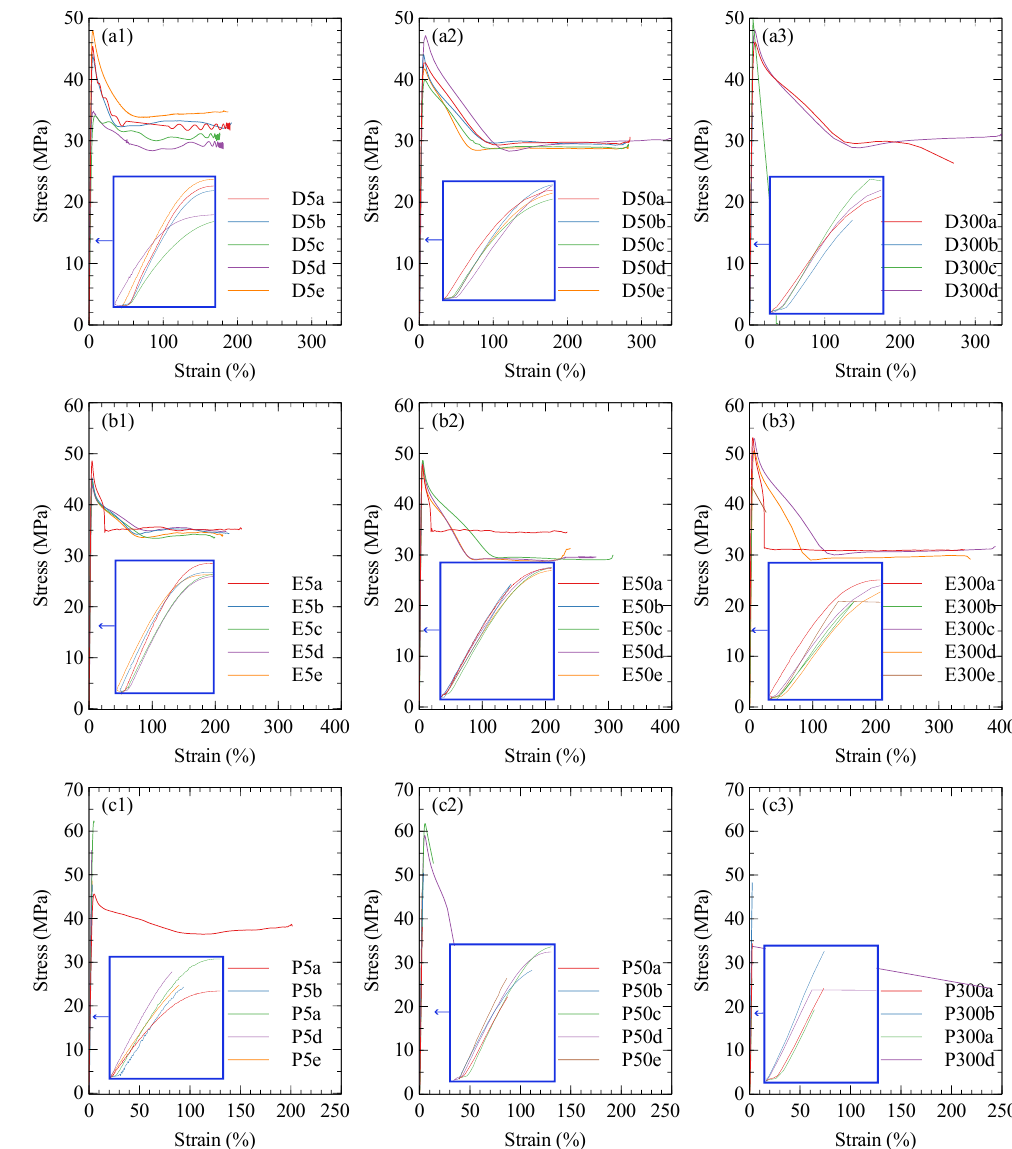
Figure 6. Nylon tensile stress–strain curves with first 5% strain inlaid. Infill geometry is denoted by ( a ) default, ( b ) on-edge, and ( c ) parallel. Tensile speeds are denoted by ( 1 ) 5 mm/min, ( 2 ) 50 mm/min, and ( 3 ) 300